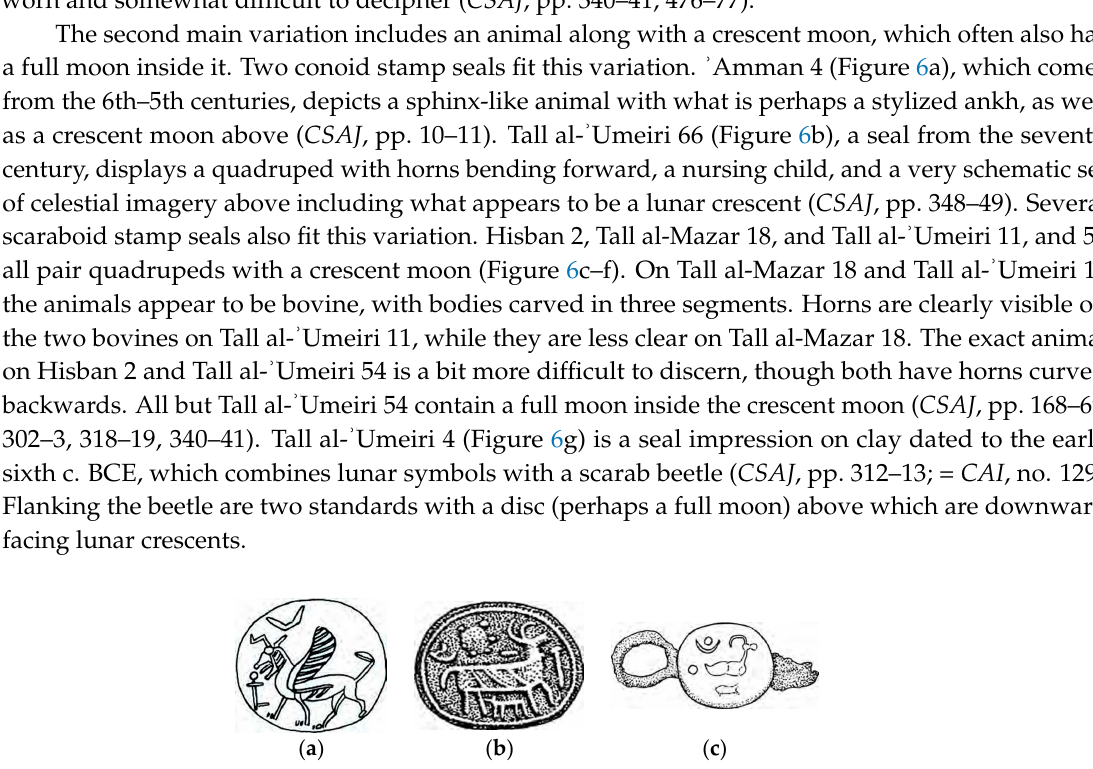
Figure 7. Seals with astral symbols: ( a ) ʿ Amman 53; ( b ) Tall al- ʿ Umeiri 39; ( c ) Umm Udeina 1; ( d ) ʿ Amman 5.